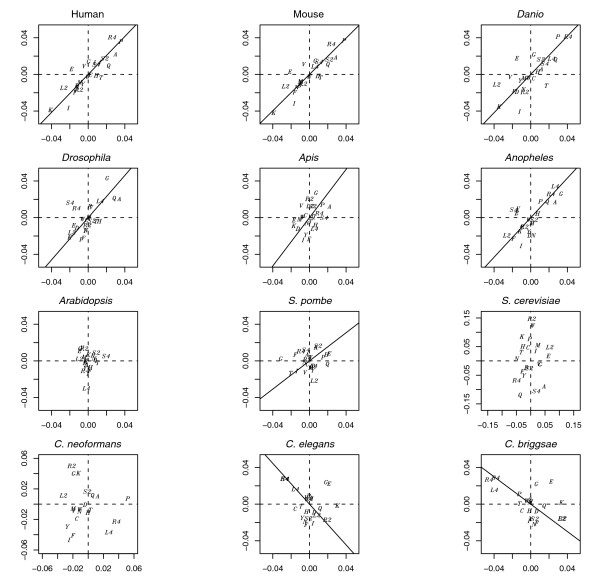
Variable symmetry in amino acid abundance trends comparing 5' and 3' exon ends within species. Intraspecific correlations between the 5' (x-axis) and 3' (y-axis) slopes as extracted from individually fitted linear models considering all 23 amino acid groupings are shown. Approximately symmetric arrangements are particularly evident for some species (notably vertebrates) whereas nematode arrangements (Ce, Cb) are not symmetric. Further notable is the higher variability of slope coefficients in some species (vertebrates and nematodes) vis-à-vis others (Am, At). Amino acids are represented by their one letter code (two-fold blocks are denoted by '2'). The regression lines are from SMA regressions. Lines were not fitted for Arabidopsis, Cryptococcus and S. cerevisiae given concerns about the adequacy of this technique for these datasets (see Materials and methods). For associated statistics consult Table 5.